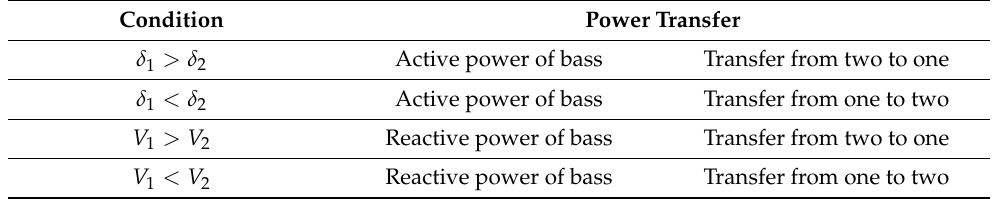
Table 1. Power transfer conditions.